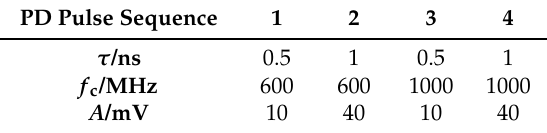
Figure 1. Simulated UHF PD signals: ( a ) Simulated PD signals; ( b ) Simulated noisy PD signals.